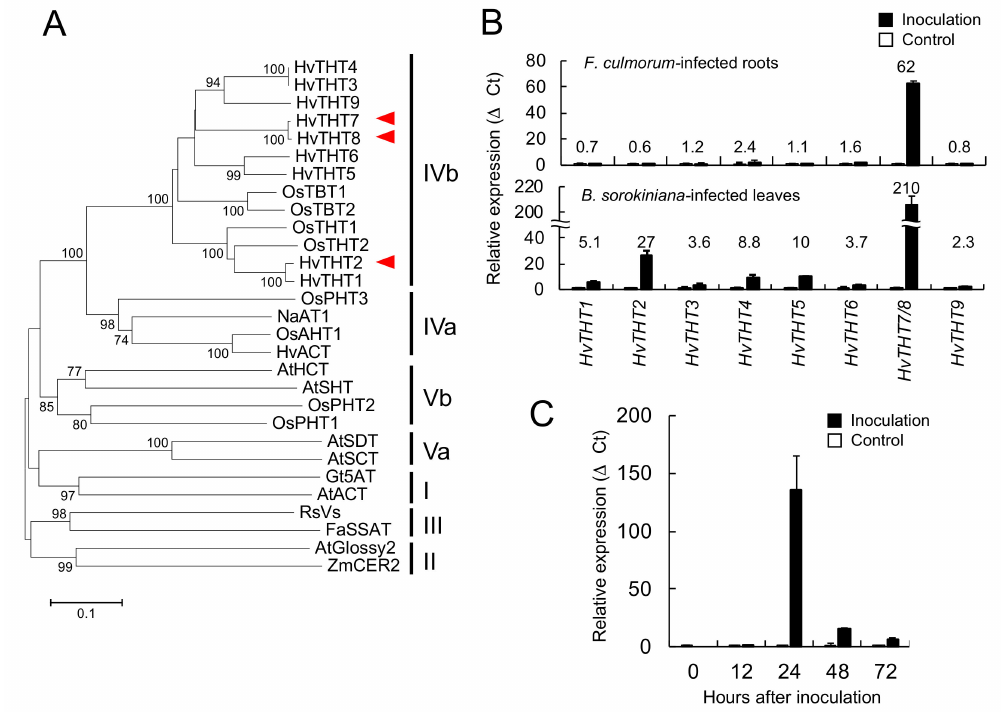
Figure 6. Involvement of barley tryptamine hydroxycinnamoyltransferases (HvTHTs) in the defense responses in barley. ( A ) Relationships between HvTHT proteins and BAHD-family acyltransferases from other species. A dendrogram was generated form sequences of 29 proteins in the BAHD family. Bootstrap values > 70% (based on 1000 replications) are indicated at each node (bar = 0.1 amino acid substitutions per